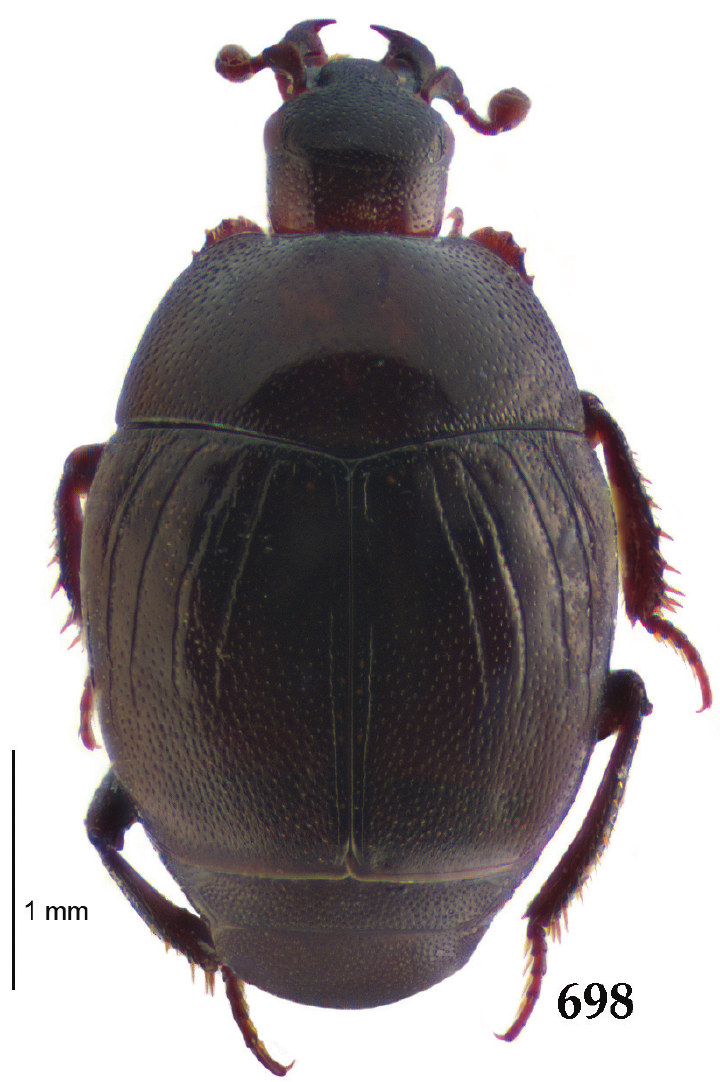
Figure 698. Tomogenius motocola Mazur, 1990 habitus, dorsal view.